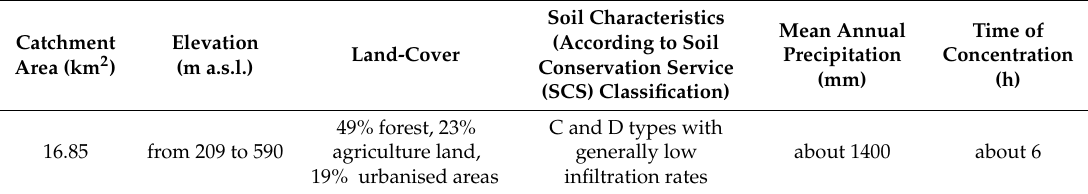
Table 1. Basic characteristics of the Glinšˇcica Stream